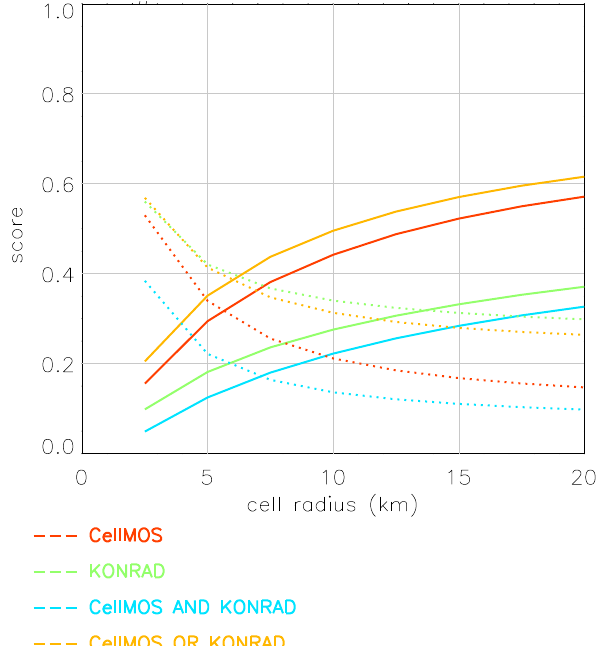
Figure 3. Areal approach. Probability of detection (solid, propor- tion of hits of all observed events) and false alarm ratio (dotted, proportion of false alarms of all forecasted events) for the compari- son of areas a ff ected by lightning strokes and areas a ff ected by cells detected by CellMOS, KONRAD, CellMOS and KONRAD, Cell- MOS or KONRAD analysis. The cell radius determines the size of the area a ff ected by a lightning stroke or a cell detected by one of the algorithms.